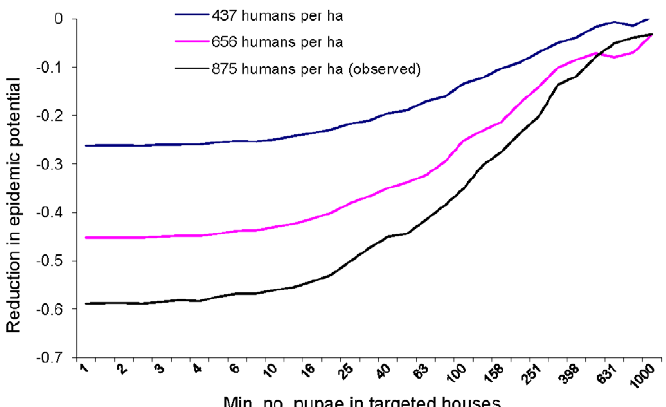
Figure 7. Effect of targeted elimination of pupae in houses with at least X pupae on reducing epidemic potential, compared with non-intervened levels. Human population density is varied relative to census-observed population. Curves represent averages across the 16 study patches. Stochastic variation is greater at highest threshold control values because few patch-surveys had more than 500 pupae in a single house.